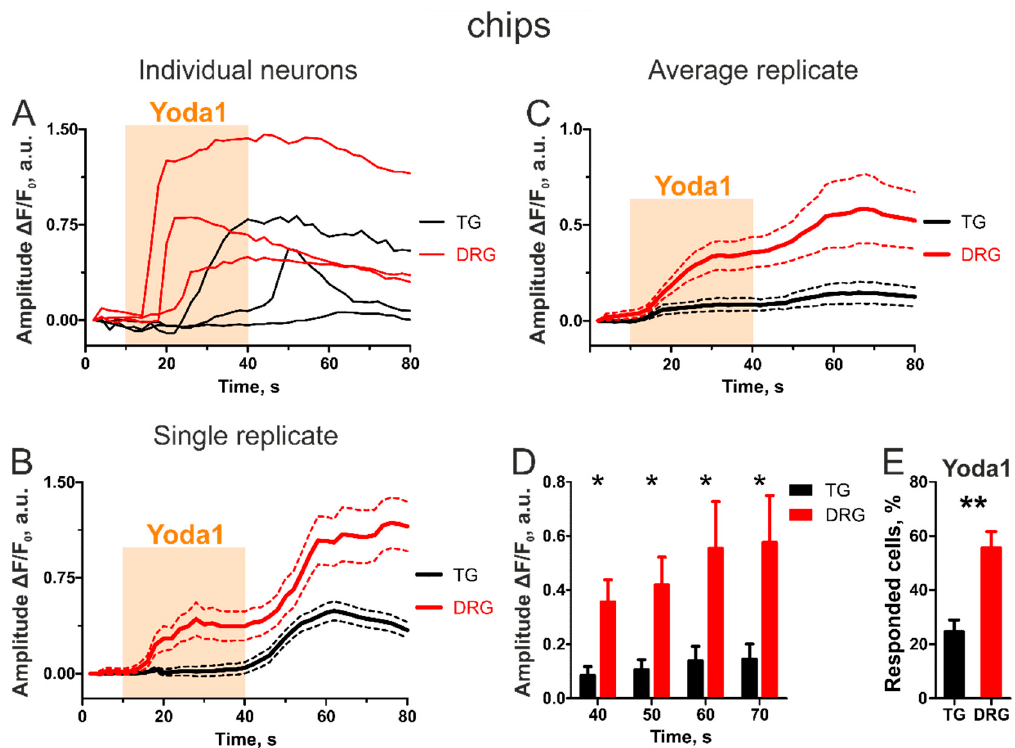
Figure 2. Yoda1-induced transients in TG vs. DRG neurons in microfluidic chips. ( A ) Sample traces of individual TG and DRG neurons. ( B ) Average neuronal responses of TG and DRG cells obtained from a single chip. ( C ) Average neuronal responses of all analyzed TG vs. DRG neurons ( n = 10 chips). ( D ) In contrast to conventional imaging, in the chips a significant difference was seen already during Yoda1 application ( n = 10 chips, * p < 0.05 by paired Student’s t -test). ( E ) Dorsal root ganglion neurons responded to Yoda1 significantly more frequently than TG neurons ( n = 10 chips, ** p < 0.01 by paired Student’s t -test).